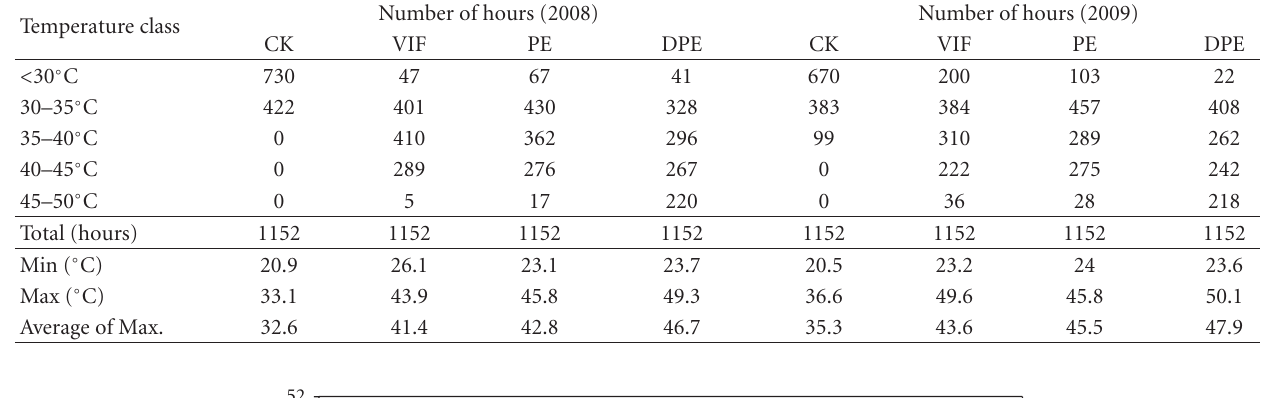
Table 1: Number of hours for di ff erent temperature classes recorded under solarization treatments (control (CK), regular polyethylene (PE), double regular polyethylene (DPE), and virtually impermeable films (VIF)) during July 6-August 22, 2008 and July 1-August 17, 2009 in Al-Aroub Agricultural Research Station, South of the West Bank.